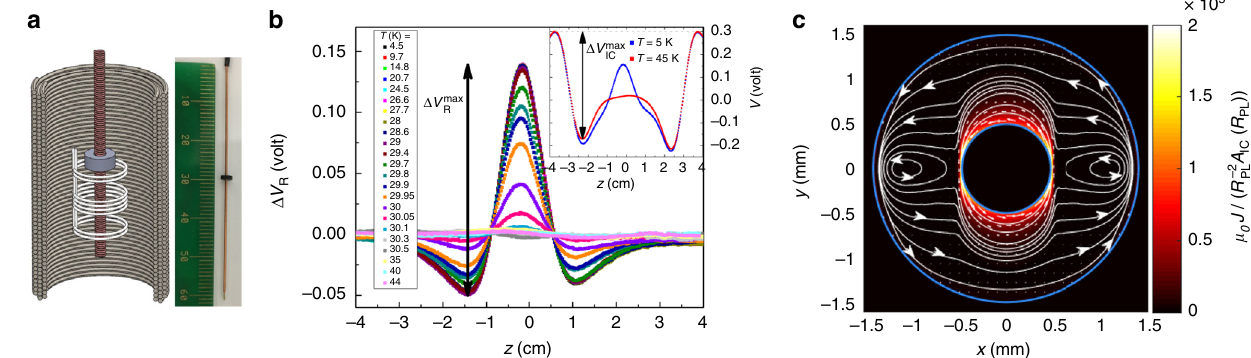
Fig. 2 Stiffnessometer. a An illustration of the Stiffnessometer operation principal and a photo of typical ring and coil with 2400 windings. The long coil is threaded through a ring and they both move with respect to a gradiometer which is connected to a SQUID. The SQUID measures the fl ux through the gradiometer and hence the average vector potential on it 〈 A θ 〉 . b Temperature dependence of an LSCO x = 0.125 c -ring signal as measured by the Stiffnessometer with I = 1 mA in the inner coil. The data presented are after subtraction of the coil contribution as explained in the text. The inset shows raw Stiffnessometer data for a temperature above and below T c . The difference is due to the ring contribution. c The currents streamlines in a-ring at midheight ( z = 0) derived from the solution of Eq. (3) with λ c = 145 μ m and λ ab = 13.9 μ m. The false colors show the current intensity. Naturally the fl ow is not isotropic. Vortices develop on both sides of the x ¼ We detect two different stiffness transition temperatures, T c s ¼ 29 : 4 K for the a -ring. 30 : 1 K for the c -ring, and a lower one T a s